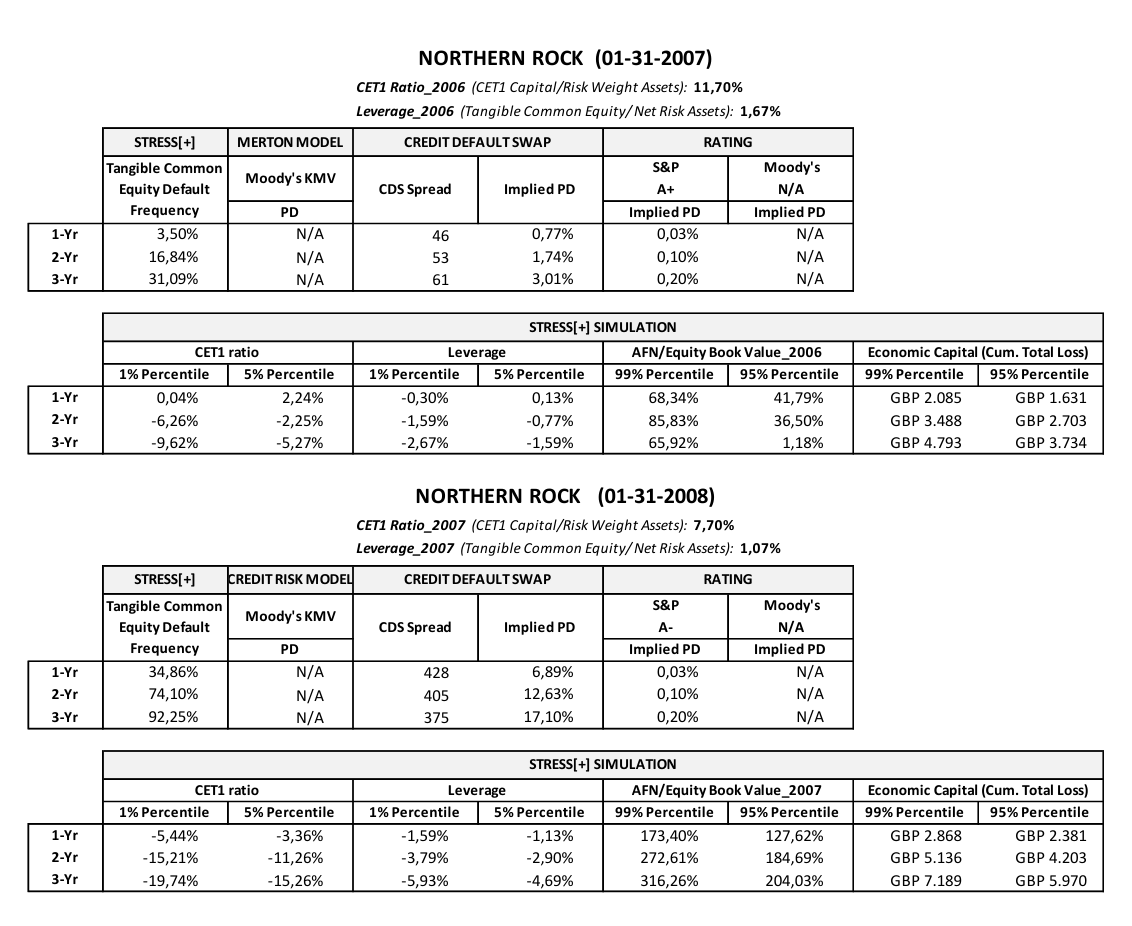
Figure A12. Backtesting comparative analysis: Merrill Lynch. (Source of CDS, KMV data, rating: Bloomberg, Moody’s KMV, Standard & Poor’s ).